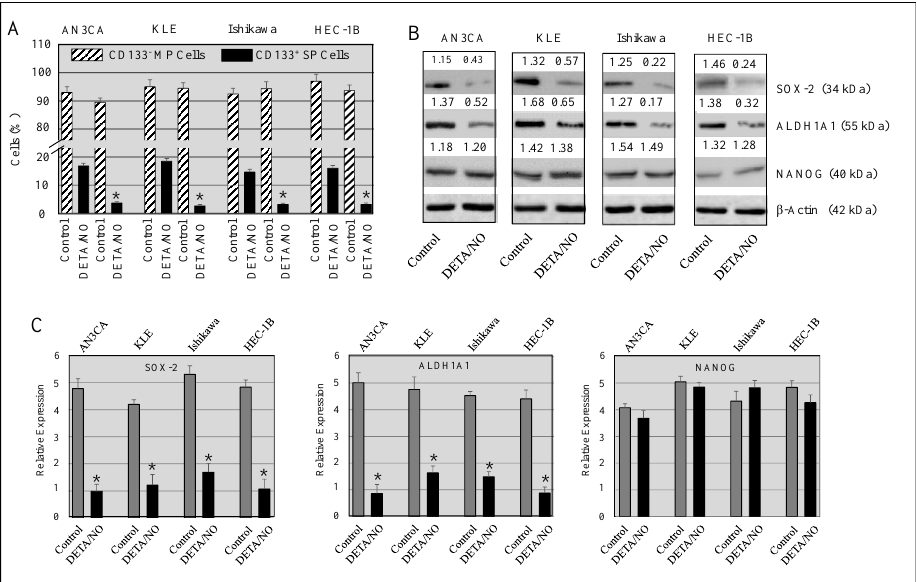
Figure 4. DETA/NO reduced the amount of the stem-like cell subpopulation in endometrial cancer. ( A ) The percentages of CD133+ (side population, SP) and CD133− (main population, MP) cells are shown in AN3CA, KLE, Ishikawa, and HEC-1B vehicle and DETA/NO-treated cells. The bars are mean ± SEM and * indicates a statistically significant difference between the vehicle and DETA/NO treated-cancer cell lines ( p < 0.05). ( B ) The expression of stem cell markers in AN3CA, KLE, HEC-1B, and Ishikawa cells treated with DETA / NO for 24 h. β -actin was used as a loading control. ( C ) The expression of stem cell markers in DETA / NO-treated and vehicle-treated cells is shown as bars after normalization to β -actin. Data are expressed as means ± SEM of three independent experiments. An asterisk * ( p < 0.05) indicates a statistically significant change between control and treatment